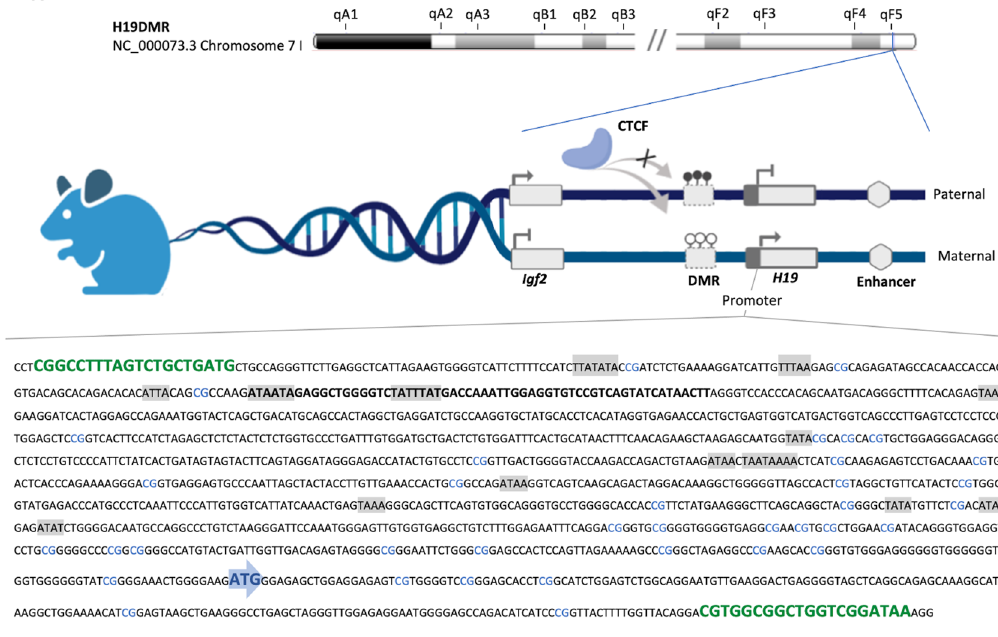
Figure 1. ( A ) Schematic representation of murine H19DMR and H19 promoter sequence (NC_000073.3 Chromosome 7 F5). The H19DMR is an imprinting control region that regulates H19 and IGF2 gene activity in an enhancer competition and insulator binding model. The differentially methylated region (DMR) near to H19 promoter is unmethylated in the maternal allele, which allows the attachment of the CTCF insulator protein and H19 expression. The insulator activity modifies the chromatin and prevents the enhancer activation of the IGF2 , which is silenced. On the paternal allele, the methylation blocks the insulator biding, whereas makes conformational modifications in the H19 promoter, which is silenced on the paternal allele, while the enhancer acts on the IGF2 gene that is paternally expressed. ( B ) H19 predicted promoter region sequence (GRCm38/ mm10 Chr7:142577859-142579404). The guide RNAs (gRNAs) (green) were designed to flank the promoter region, including 1301 base of pairs (bp) upstream and 225 bp downstream to the start codon “ATG” (blue arrow) of the first exon. 14 TATA Box sequences (highlighted in grey) were